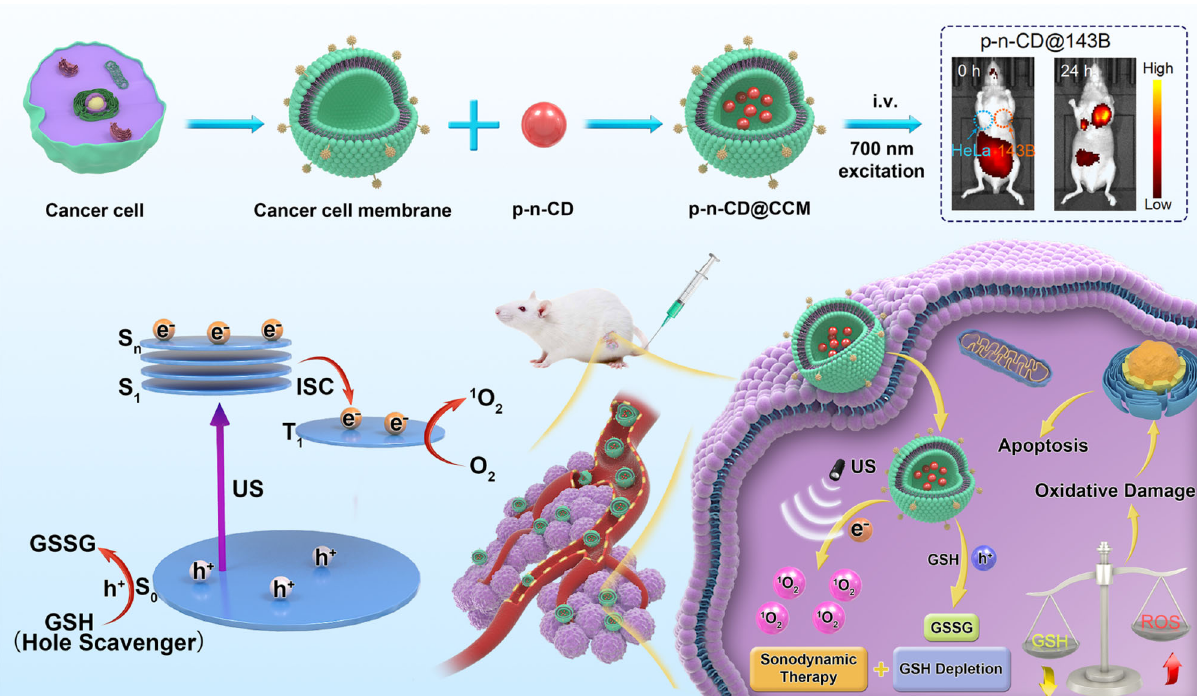
Fig. 1 | Design and mechanism of p – n-CD@CCM for sonodynamic precision cancertherapy. SchematicillustrationofcancercellmembraneencapsulatedNIR-